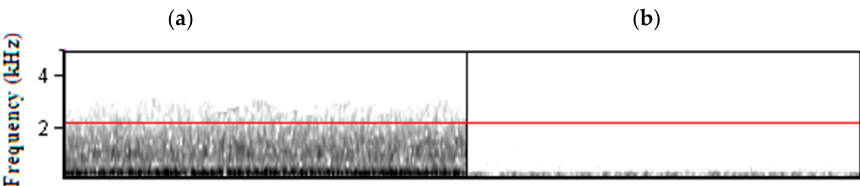
Figure 2. Spectrograms of ambient noise at ( a ) urban and ( b ) rural sites.